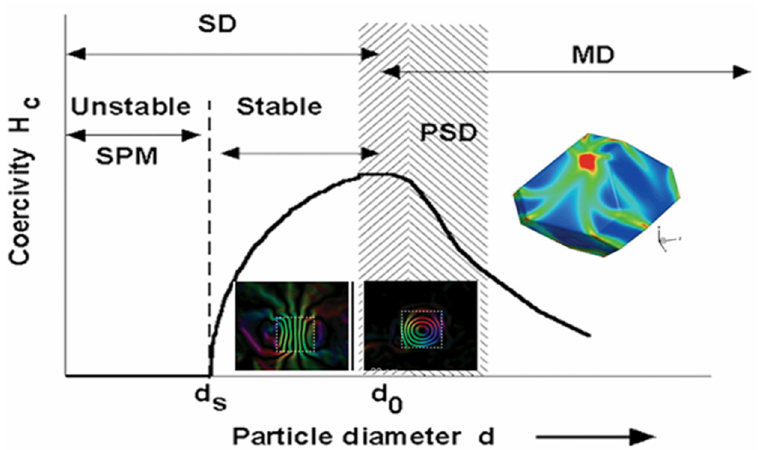
Figure 5. Schematic representation of the transitional state in magnets that spans the particle size range between SD and MD states. The inset collar pictures indicate the direction of the magnetic induction in magnetite particles with 25 nm, 200 nm, and microns sizes, modified from. Reprinted with permission [82]. Copyright 2021, American Chemical Society.